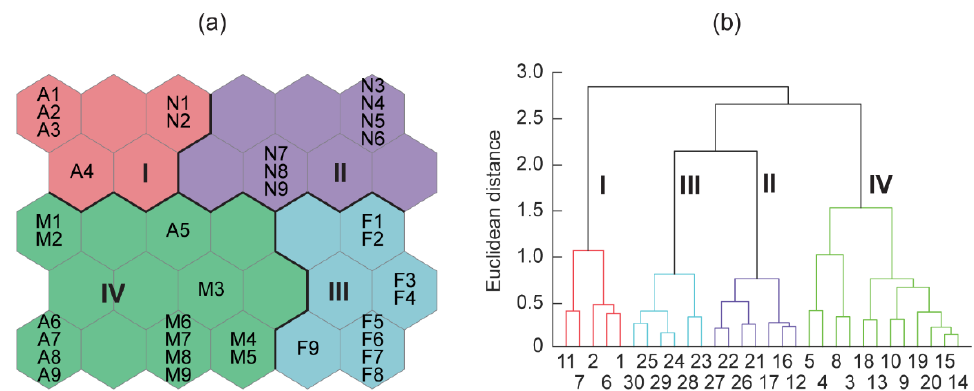
Figure 2. ( a ) Classification of the samples according to time and space on the Kohonen self-organizing map (SOM) trained with biogeochemical parameters. The acronyms of individual samples are denoted by a combination of the sampling month (February [F], May [M], August [A], and November [N]) and the number of the station (1 – 9). ( b ) Dendrogram of the trained SOM units for four clusters based on Ward’s linkage method. The numbers are noted from top to bottom and from left to right on the map. Clusters are indicated by different colors and corresponding numbers.